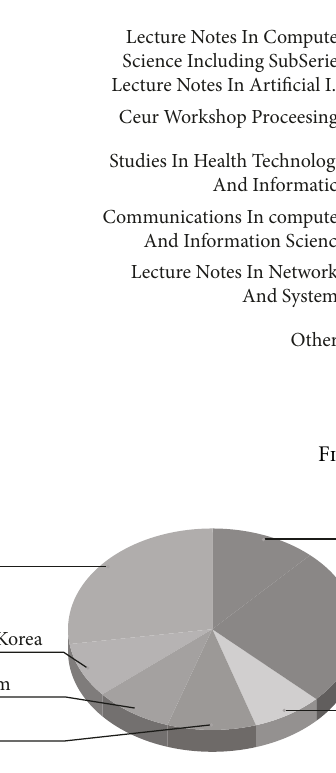
Figure 5: Country-wise article